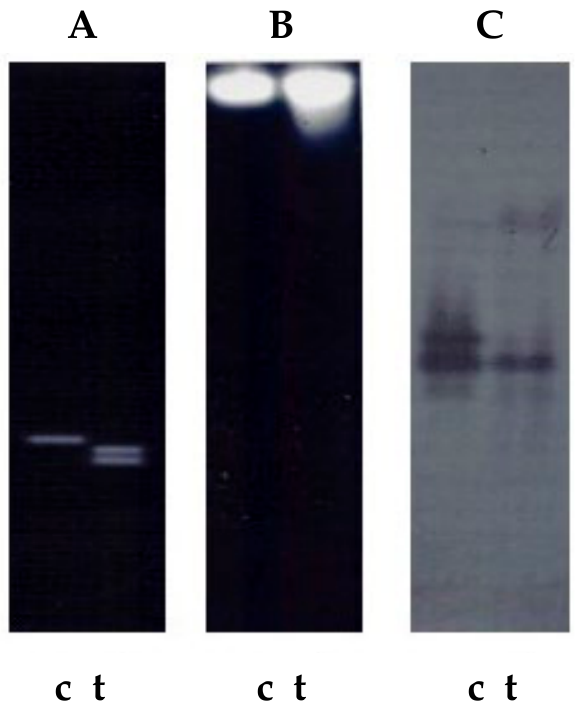
Figure 3. Isoenzyme pattern and activity staining of APX (A), CAT (B) and DHAR (C) enzymes after native electro- phoresis, for Chenopodium album plants treated with As- cochyta caulina toxin mixture (t), or untreated (c), 24 h after treatment. In each lane, 200 μg total proteins were loaded. The gels were analysed utilizing the Gel Doc (see Materials and